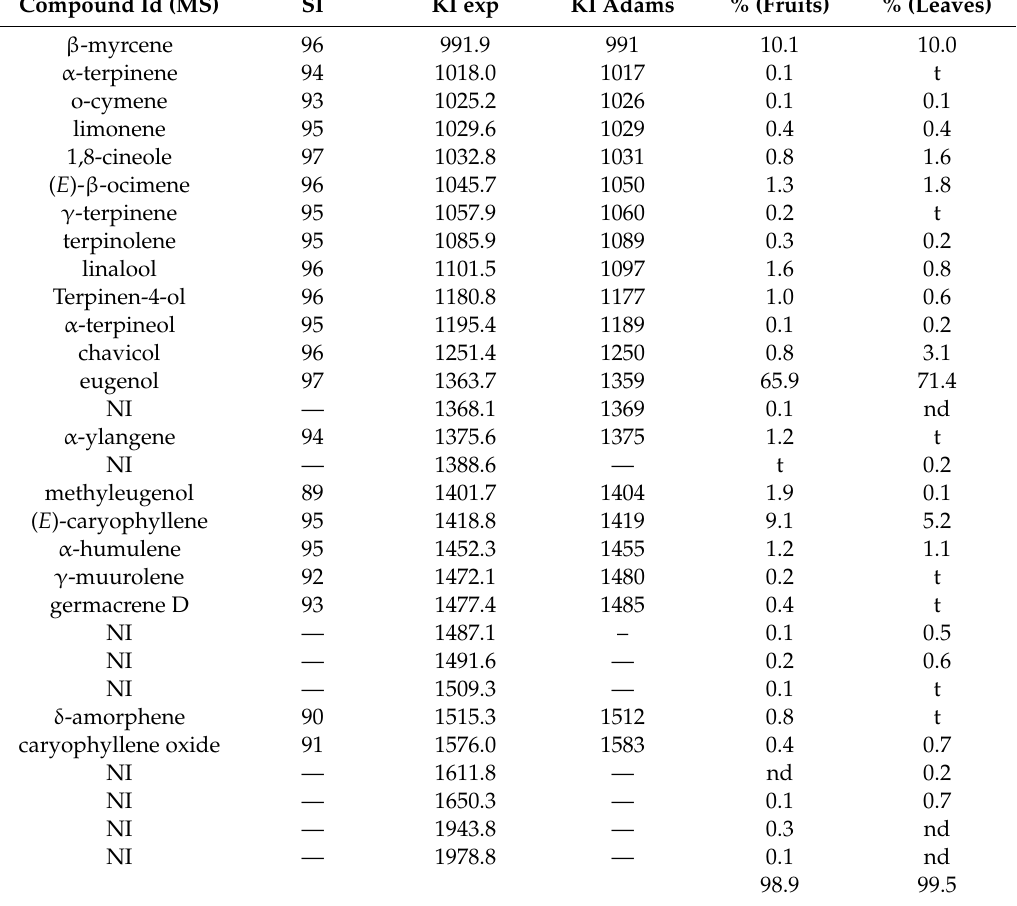
Table 1. Composition of the essential oil of fruits and leaves of P. dioica determined by gas chromatography coupled to mass spectrometry analysis (GC / MS) and Retention Index (KI). Compound Id